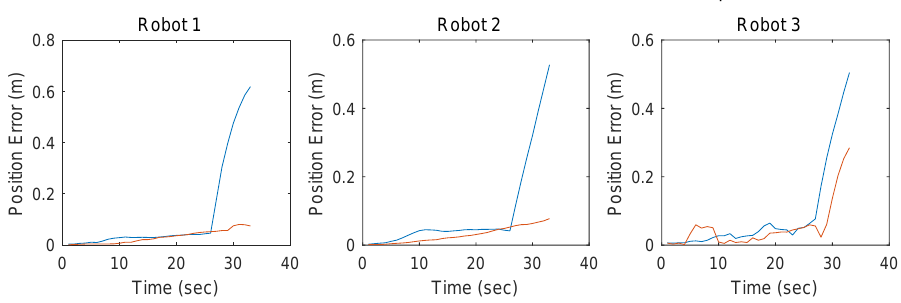
Figure 10. Position errors of 3 robots under additive white Gaussian noise and impulse noise.